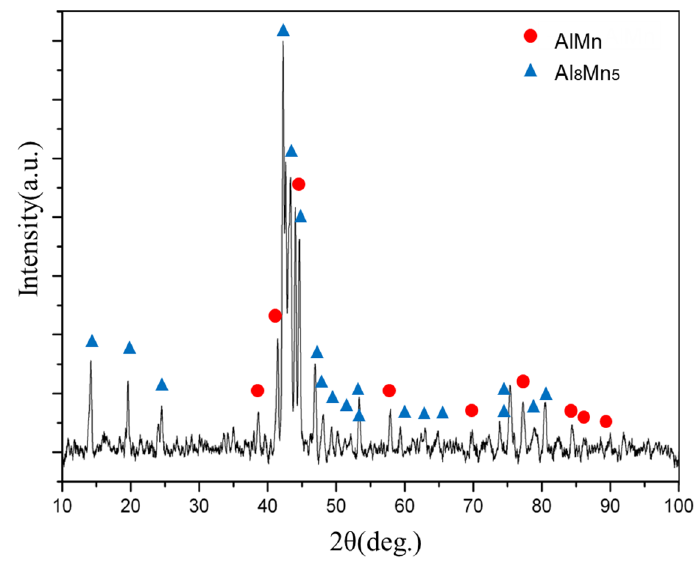
Figure 9. XRD spectrum of 27 wt.% Al-73 wt.% Mn master alloy ribbons.